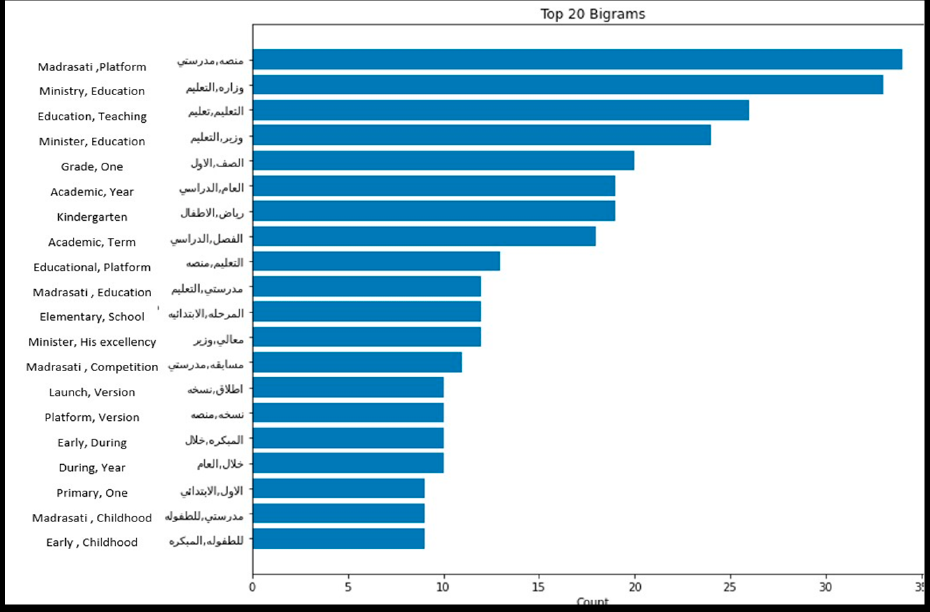
Figure 9. Top 20 Frequent words from the primary schools’ and kindergartens’ positive tweets.